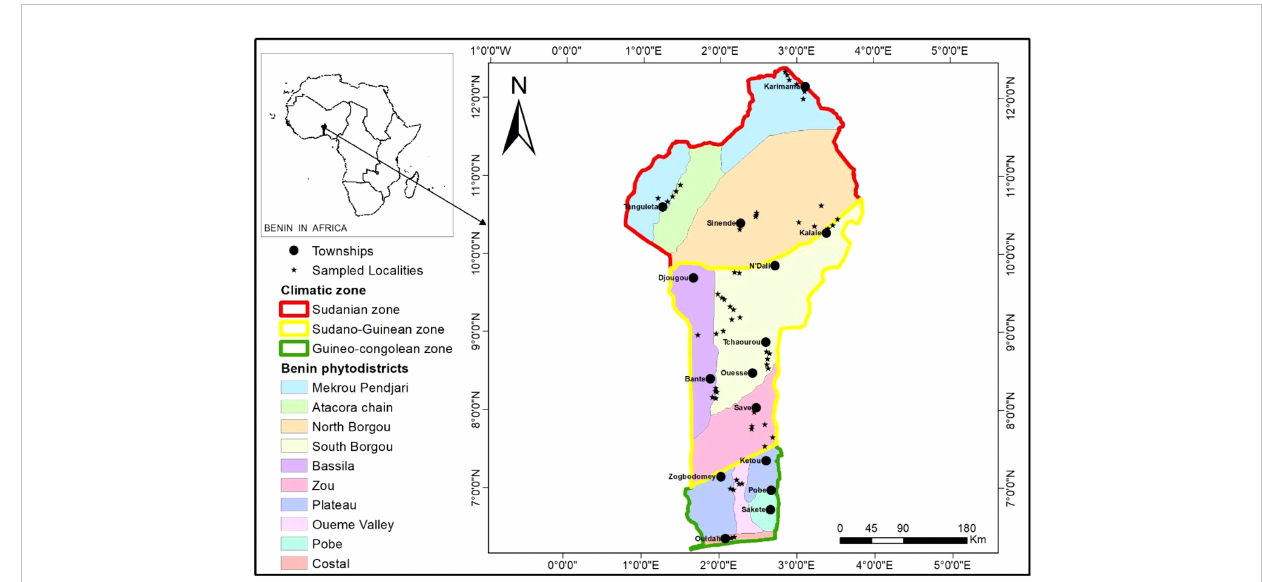
FIGURE 1 Situation map of the study